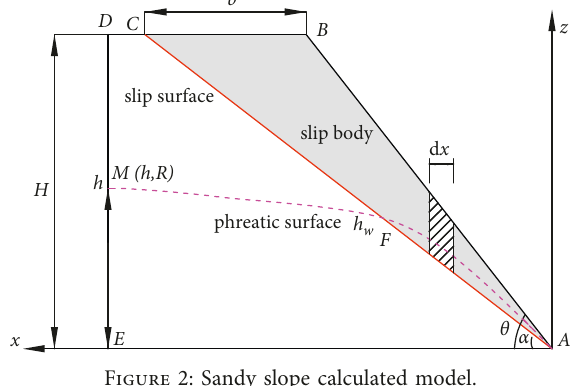
Figure 2: Sandy slope calculated model.